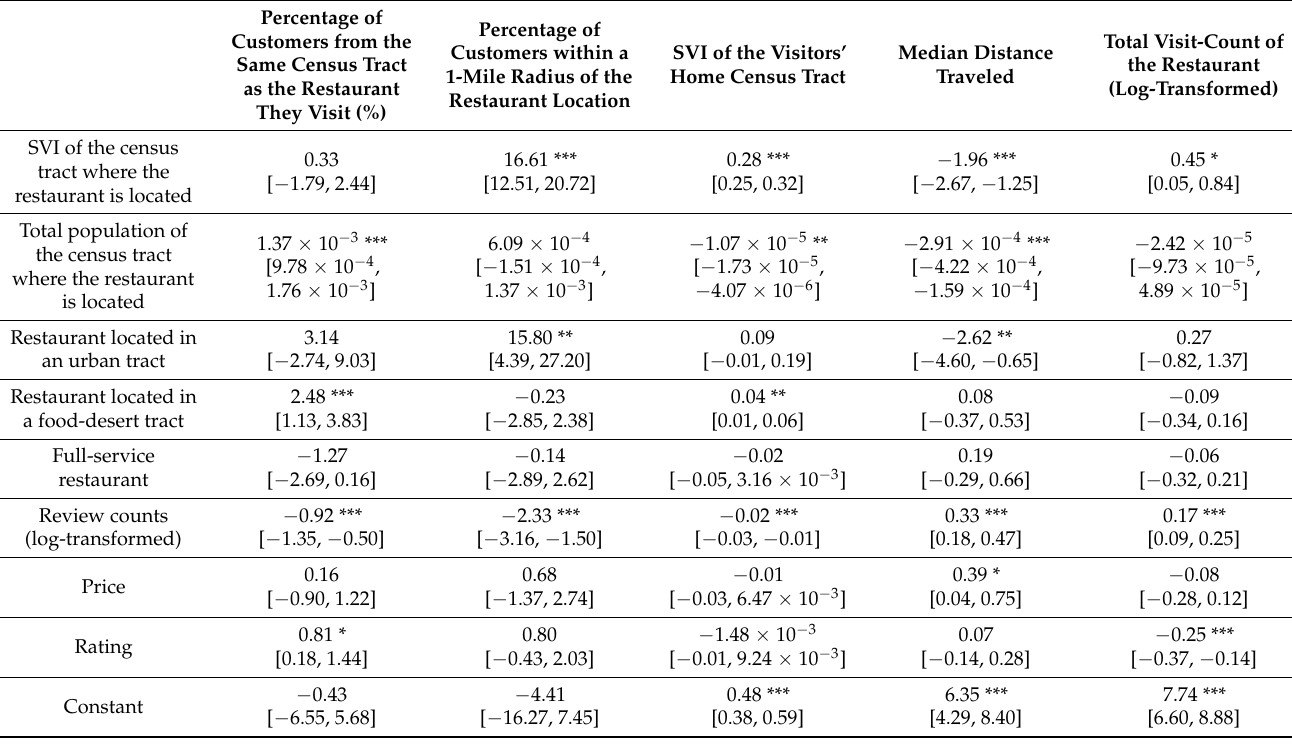
Table 2. The results of multivariate-linear-regression